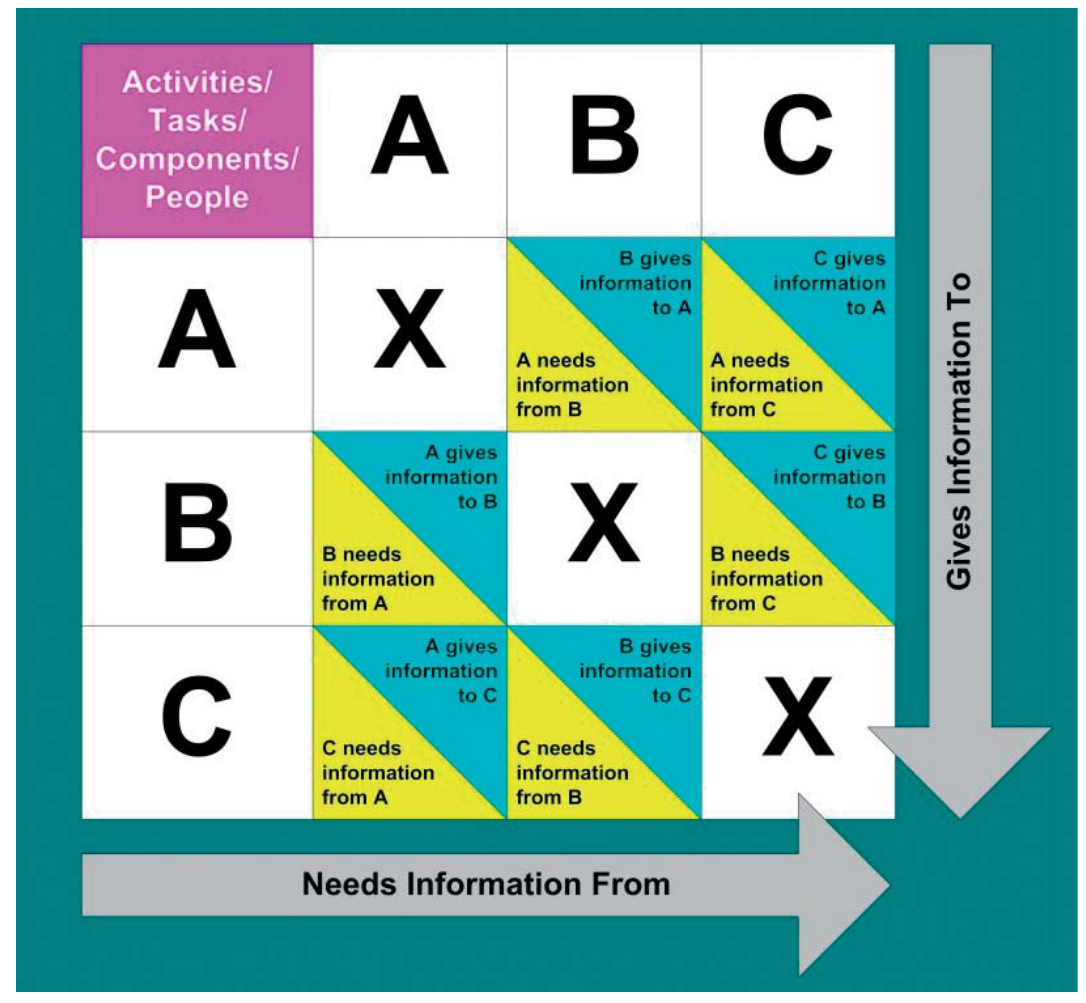
Figure 2: Matrix representation of relations and